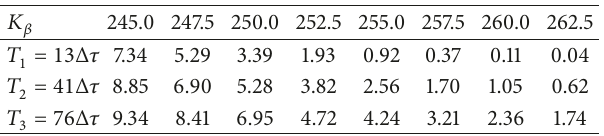
Table 5: KOSPI 200 index call option price on 29 July 2016 with respect to the strike and